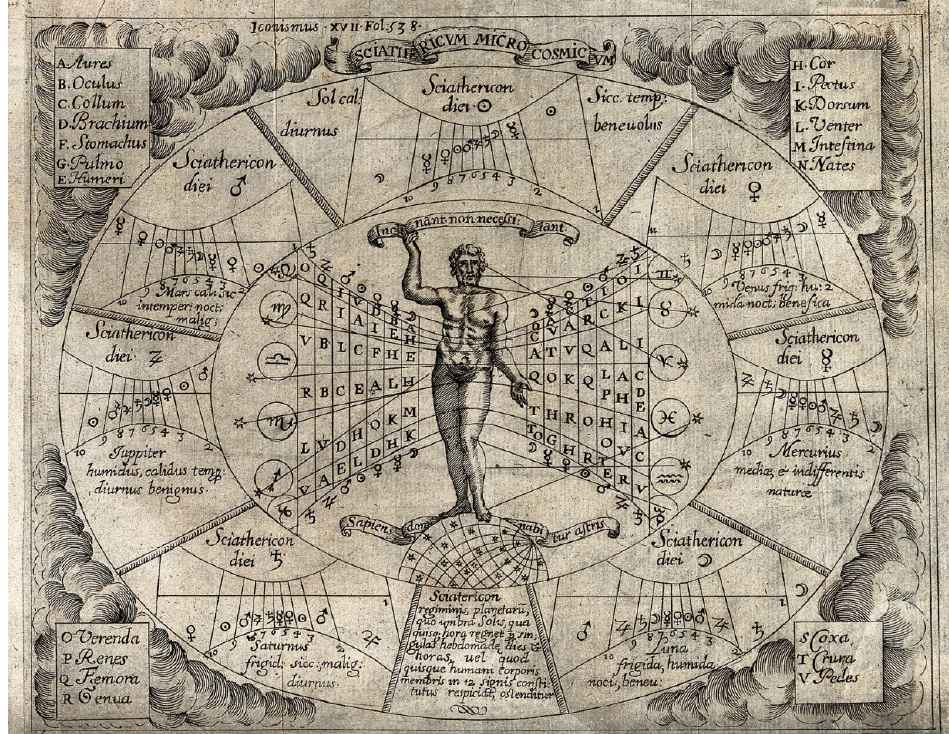
Figure 1. An oval chart showing how different planets affect different parts of a man’s body. En- graving by Pierre Miotte, for Athanaius Kircher, Ars magna lucis et umbrae (Rome: Hermanni Scheus, 1646), Icononismus XVII, fol. 538. Wellcome Collection. 46389i. Public Domain.